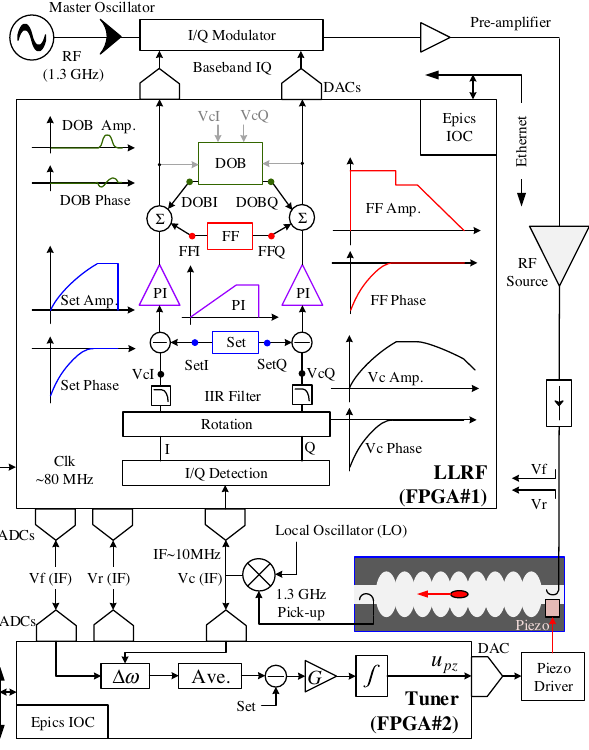
FIG. 2. Schematic of the digital LLRF and tuner system in the cERL. The pulse patterns for the cavities in the main linac are illustrated in the figure for better explanation.